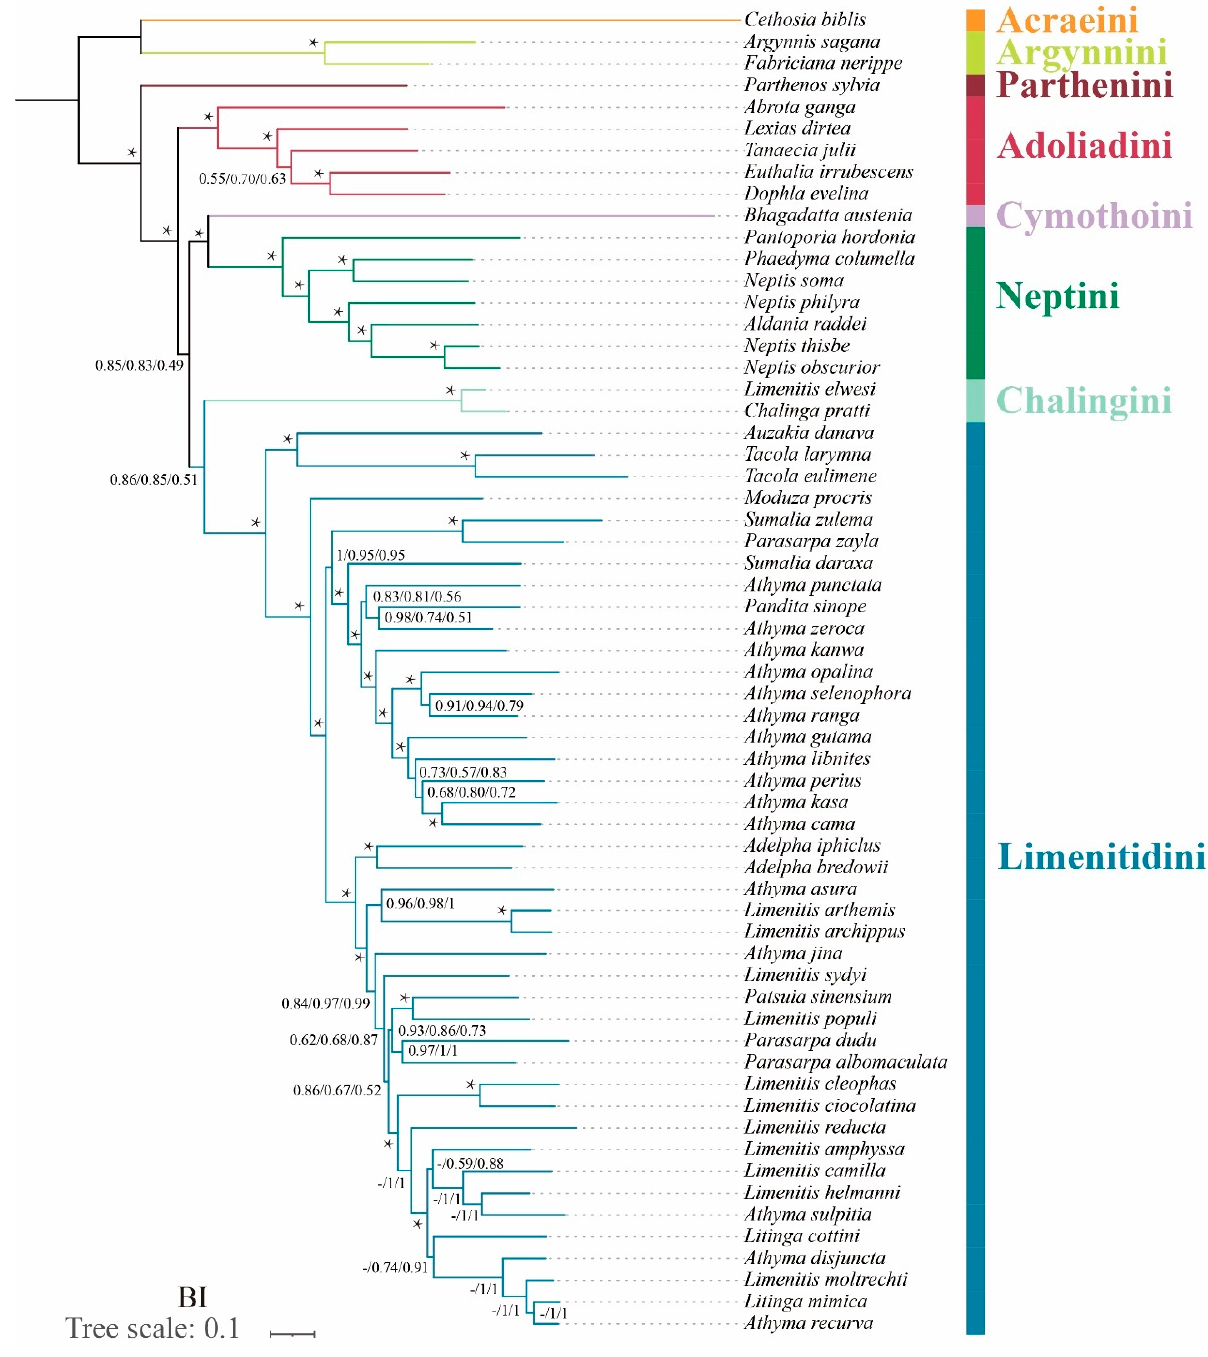
Figure 5. Phylogenetic tree produced by Bayesian inference analyses based on the datasets of PCG123, PCG123R and PCG123RT. Supports at nodes (from left to right) are posterior probability (BPP) for PCG123, PCG123R and PCG123RT. “-” indicates the clades are different. Star symbol indicates that three datasets produced a maximum support value.